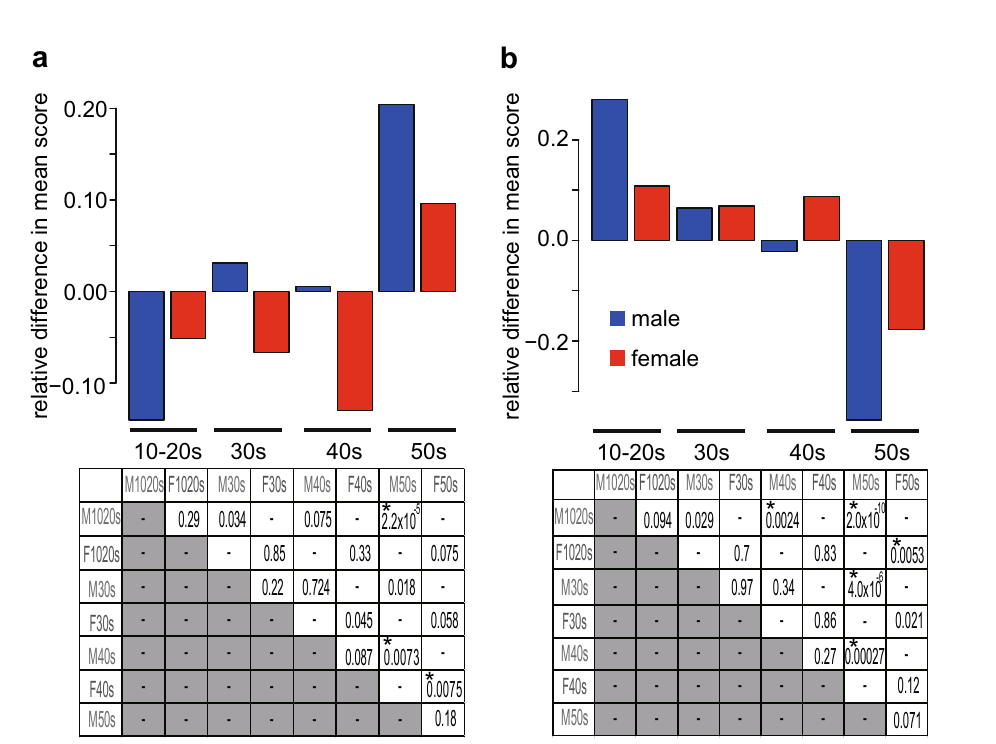
Figure 1. Age- and gender-dependent differences in willingness ( a ) and refusal ( b ) to be vaccinated. The upper panels show relative differences in the mean willingness/refusal (group mean minus total mean) (male; blue, female; red). The lower panels represent p-values of t-tests between the two groups. Significance after the correction for multiple comparisons is indicated by